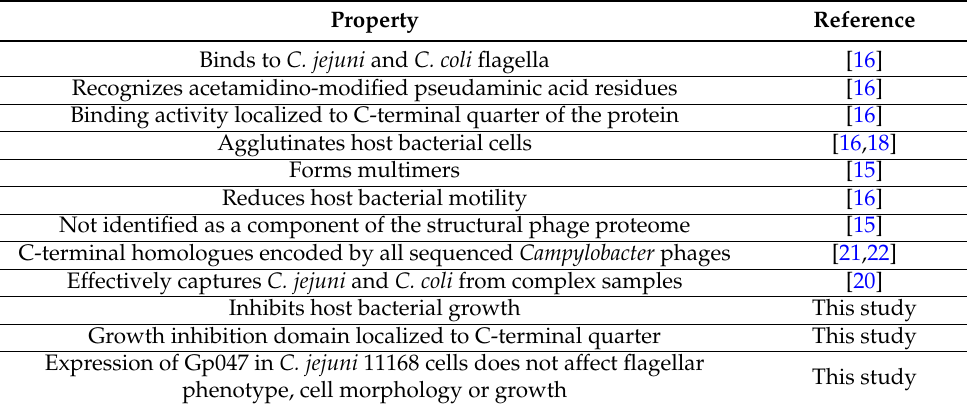
Table 1. Summary of Gp047 properties characterized to date.